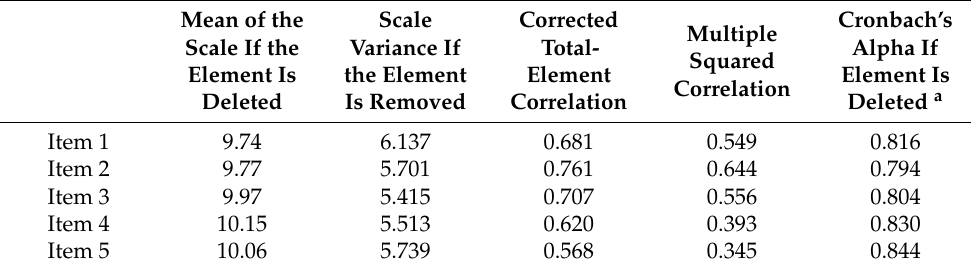
Table 3. Item analysis of the Spanish Version of the Short Form of the Fonseca Anamnestic Index (SFAI).